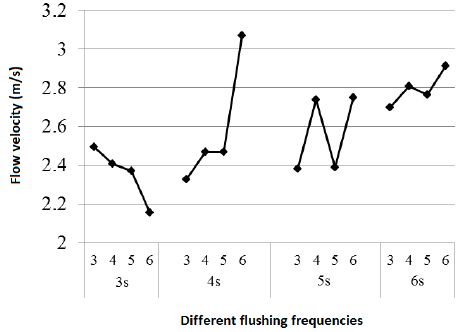
Figure 20. Flow velocity comparison of all the frequencies (rectangular nozzle at the bottom of the